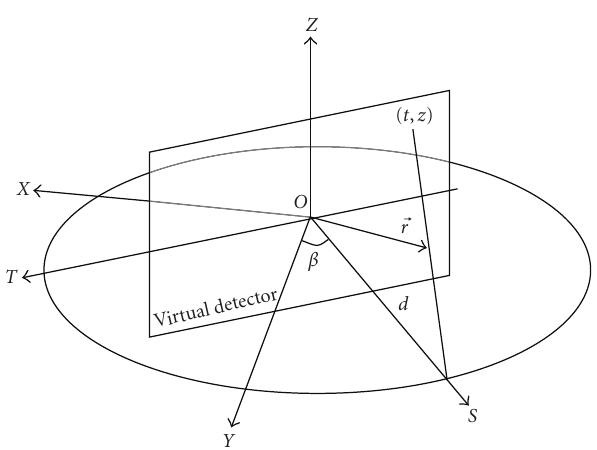
Figure 4: The geometric illustration of a circular